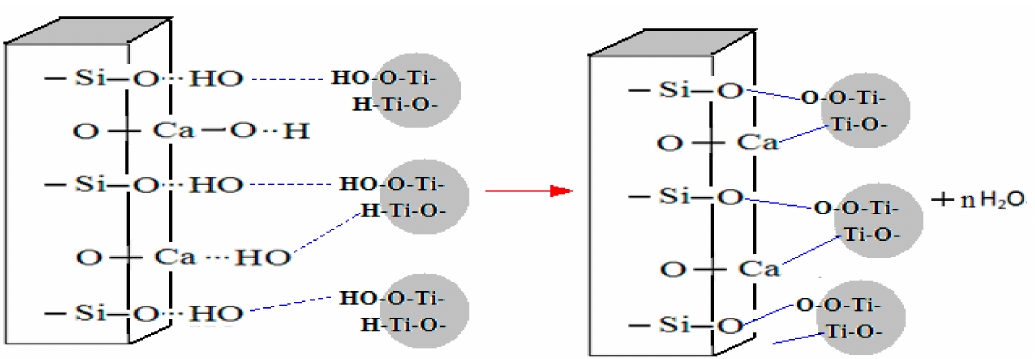
Figure 11. The interaction model on the surface of wollastonite and TiO 2